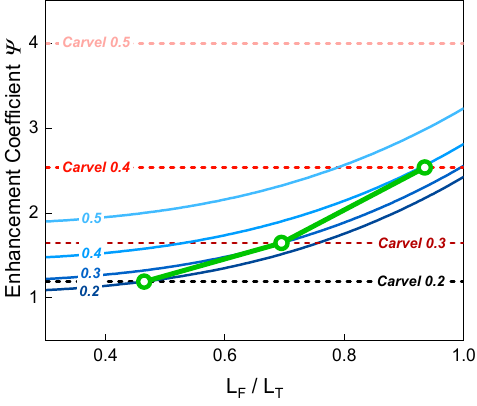
Figure 23. Determination of the appropriate ranges of L F / L T where the current model works.